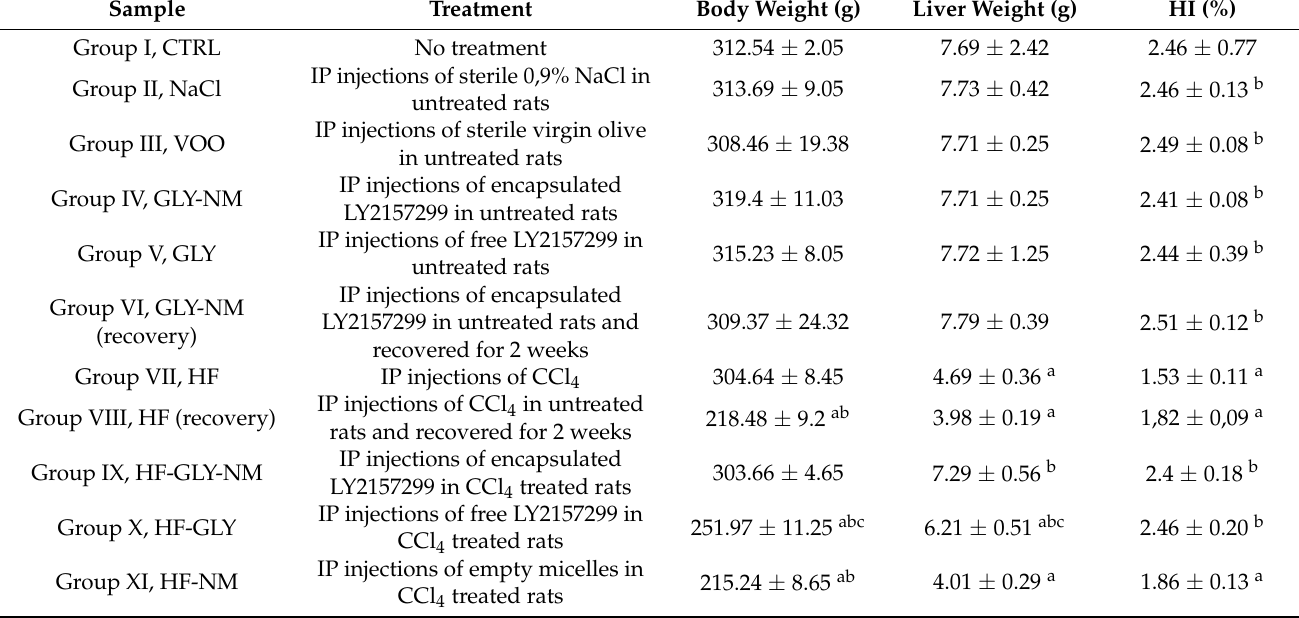
Table 1. Body and liver weights and hepatic index. Values are expressed as mean ± SD (n = 8). Hepatic Index is expressed as the percentage of the liver weight with respect to the total animal weight. CTRL (Group I): Control untreated rats were allowed free access to food and water. NaCl (Group II): Rats intraperitoneal injected with sterile 0.9% NaCl solution three times a week for two weeks. VOO (Group III): Rats intraperitoneal injected with sterile virgin oil three times a week for two weeks. GLY-NM (Group IV): Untreated rats administered with encapsulated Galunisertib-LY2157299 (GLY-NMs) (GLY-NMs safety assessment); GLY (Group V), GLY: Untreated rats administered with free Galunisertib-LY2157299 (GLY) alone (GLY safety assessment); GLY-MN (recovery) (Group VI): Untreated rats administered with encapsulated Galunisertib-LY2157299 (GLY-NMs) followed by additional 2 weeks with free access to food and water (GLY-NMs safety assessment); HF (Group VII): Hepatic fibrosis (HF) model; HF (recovery) (Group VIII): HF rats were left to recover for two weeks after the last injection of CCl 4 with free access to food and water (control of immune system responses); HF-GLY-NM (Group IX): HF rats treated with encapsulated Galunisertib-LY2157299 (GLY-NM) (proposed therapeutic model); HF-GLY (Group X): HF rats treated with free Galunisertib- LY2157299 (GLY) (positive control of proposed therapeutic model); HF-NM (Group XI): HF rats were intraperitoneal injected with empty micelles three times a week for two weeks after the last injection of CCl 4 (negative control of proposed therapeutic model). Significative values were reported with respect to Group I CTRL, a = p < 0.05; to Group VII HF, b = p < 0.05; to Group IX HF-GLY-NM, c = p <